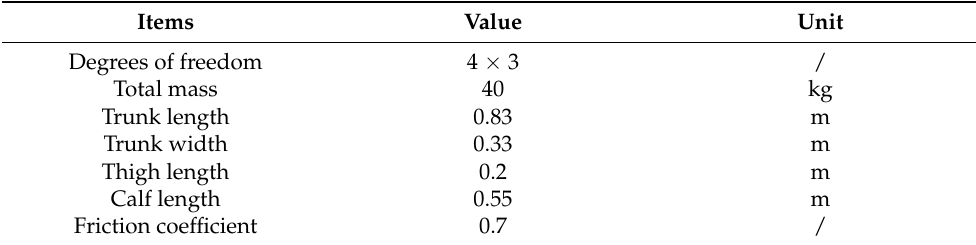
Table 1. Parameters of model in simulation and